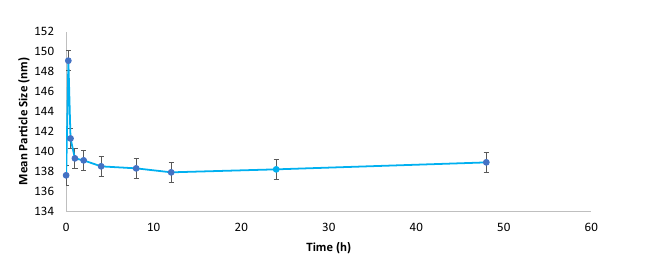
Figure 3. ZN-RSV NPs serum stability .